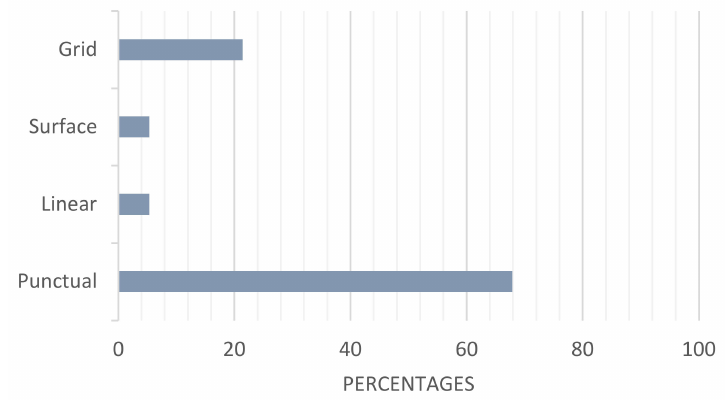
Figure 10. Percentage distribution of cases according to the geometry of the reference